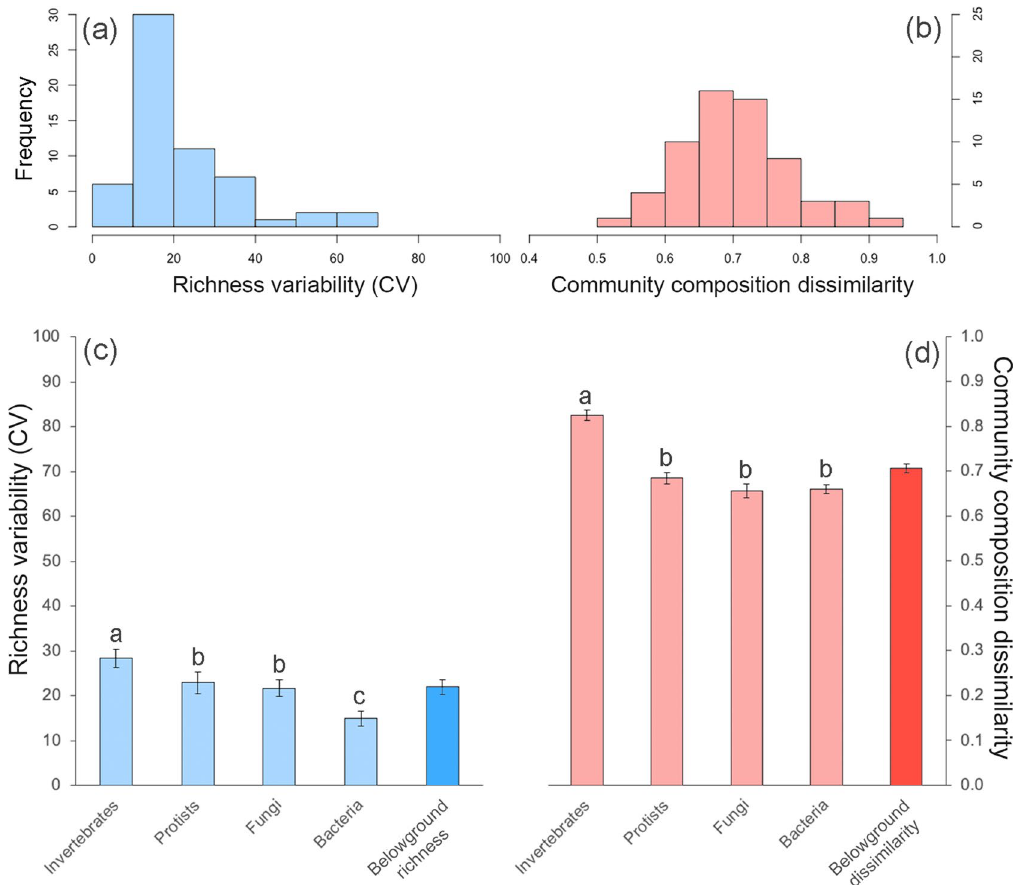
Figure 1. Absolute frequency histogram of the spatial variability of soil richness (coefficient of variation) ( a ) and community composition dissimilarity ( b ), as well as average values and standard errors values of the spatial variability of soil richness ( c ) and community composition dissimilarity ( d ) for the different taxa and for our indices of site-level belowground spatial variability of soil richness and community composition dissimilarity. Different letters show significant differences among taxa (permutational pairwise comparisons; P <